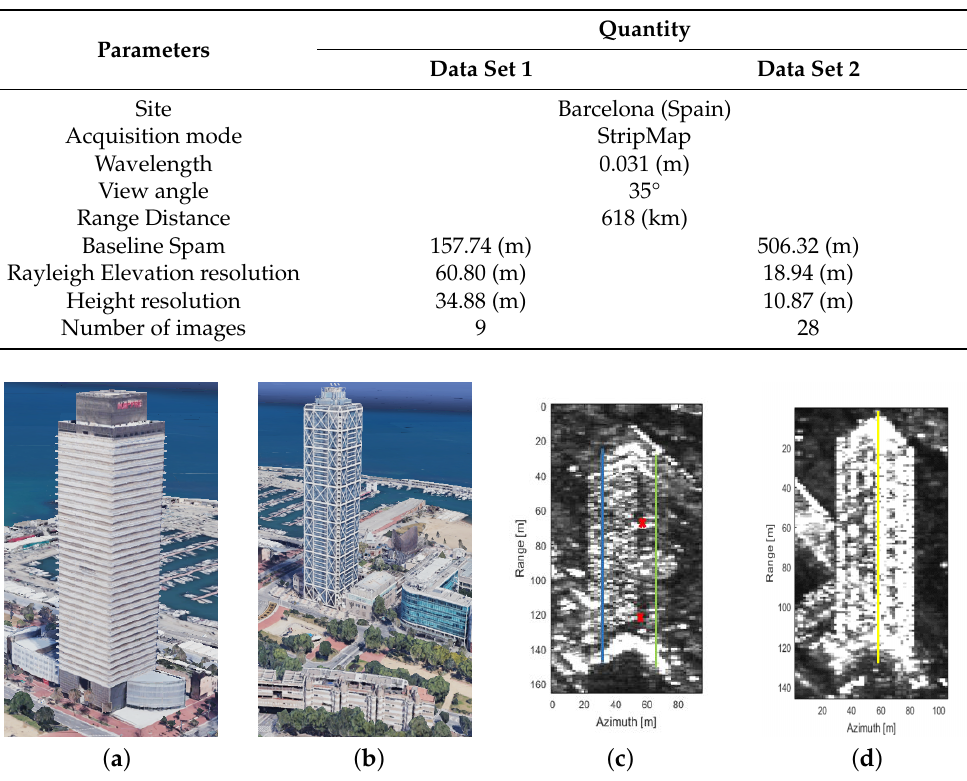
Table 1. TSX parameters of our data sets.